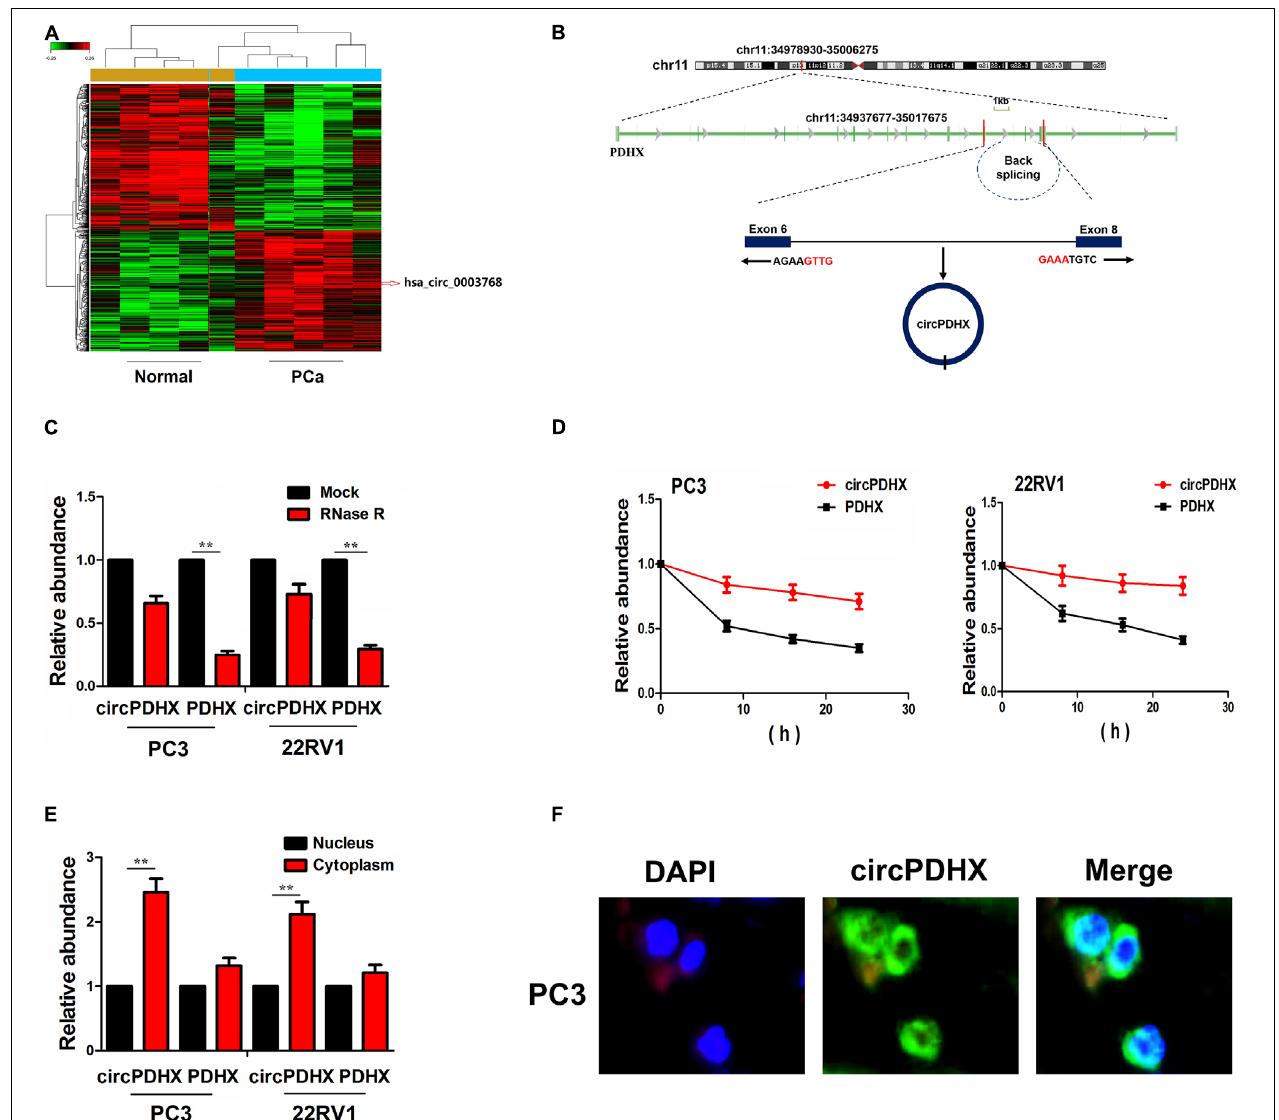
FIGURE 1 | Identification of a novel circPDHX in prostate cancer (PCa) cells. (A) Gene Expression Omnibus (GEO) dataset analysis of the differentially expressed circular RNAs (circRNAs) between PCa and normal tissues. (B) The genomic loci of the PDHX gene and circPDHX. Arrows represent divergent primers that bind to the genomic region of circPDHX. (C) Quantitative real-time PCR (qRT-PCR) analysis of circPDHX and PDHX expression levels after treatment with RNase R in PC3 and 22RV1 cells. (D) qRT-PCR analysis of the half-life of circPDHX and PDHX after treatment with actinomycin D in PC3 and 22RV1 cells. (E,F) qRT-PCR and FISH analysis of the localization of circPDHX in PC3 and 22RV1